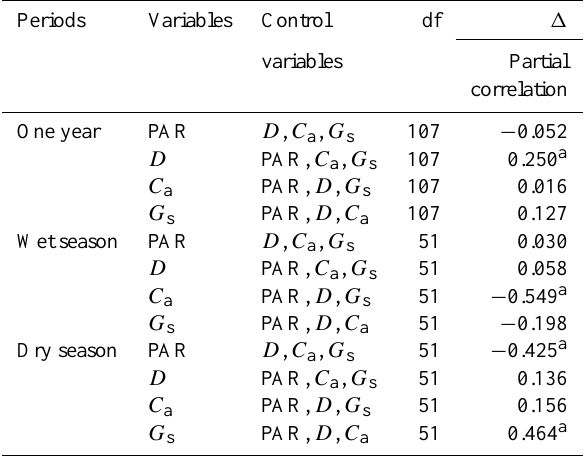
Table 2. Partial correlations between hourly 1 and photosynthet- ically active radiation (PAR), vapor pressure deficit ( D ), ambient CO 2 concentration ( C a ), and canopy stomatal conductance ( G s ).